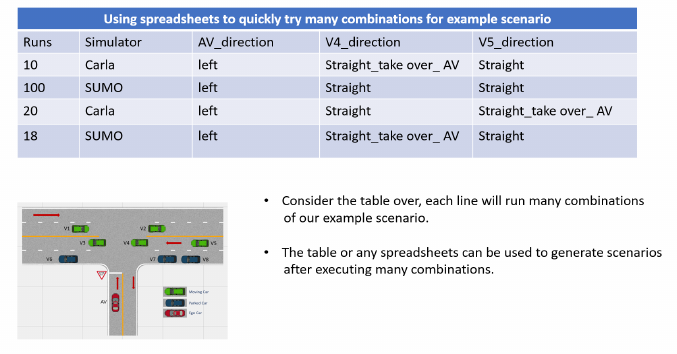
Figure 12. Using spreadsheets to try combination by M-SDL [48].